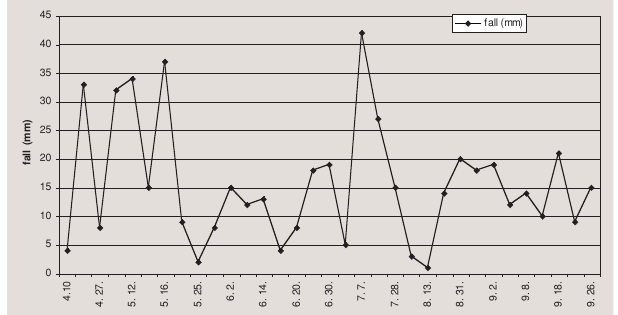
Figure 2. Rainfall amount in 2010 ( Debrecen–Pallag, 2010) 051015202530354045 4 . 104 . 27 . 5 . 12 . 5 . 16 . 5 . 25 . 6 . 2 . 6 . 14 . 6 . 20 . 6 . 30 . 7 . 7 . 7 . 28 . 8 . 13 . 8 . 31 . 9 . 2 . 9 . 8 . 9 . 18 . 9 . 26 . f a ll ( mm ) fall(mm)